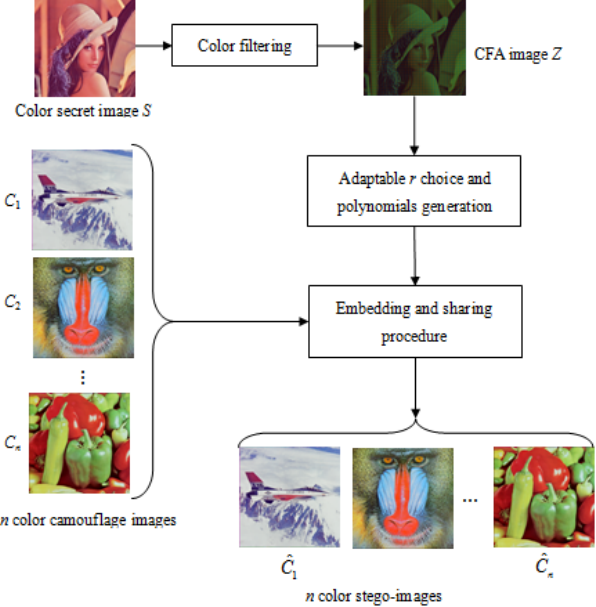
Fig. 5. Block diagram of the proposed CFA color secret image sharing